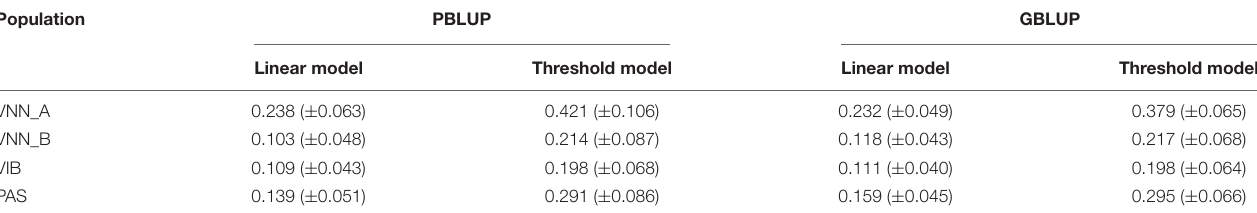
TABLE 2 | Heritability estimated for Viral Nervous Necrosis (VNN) resistance in two European sea bass commercial cohorts (VNN_A and VNN_B), vibriosis resistance in one European sea bass commercial cohort (VIB) and pasteurellosis resistance in one gilthead sea bream commercial cohort (PAS) with pedigree-BLUP (PBLUP) or genomic-BLUP (GBLUP) using linear or threshold models using full density chips.